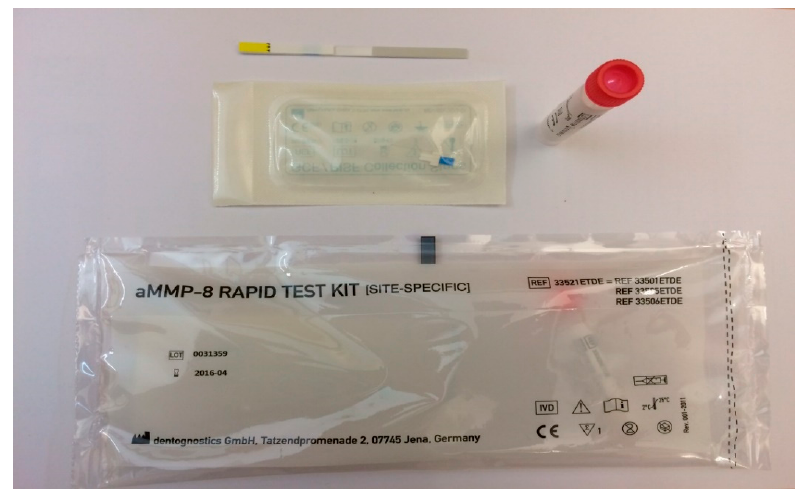
Figure 4. ImplantSafe rapid test kit to detect peri-implantitis.